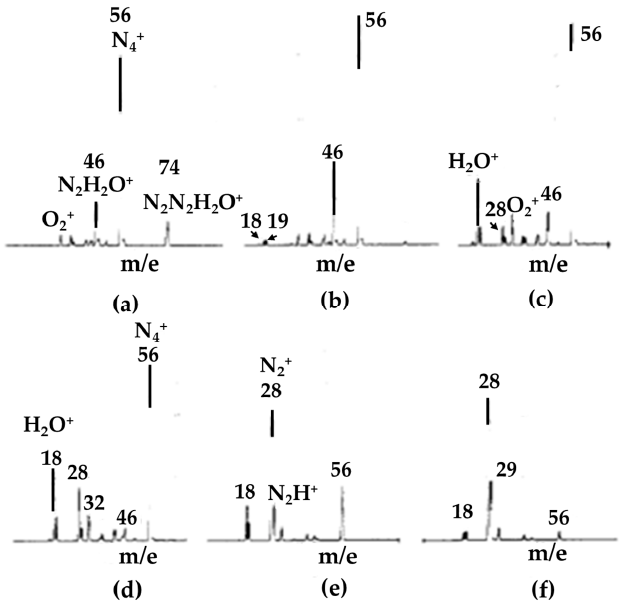
Figure 5. Drift voltage dependence of mass spectra for dry nitrogen. ( a ) 5 V, ( b ) 10 V, ( c ) 18 V, ( d ) 22 V, ( e ) 30 V, ( f ) 40 V. Figure adapted from [36] with permission. Copyright 1979 American Chemical Society.